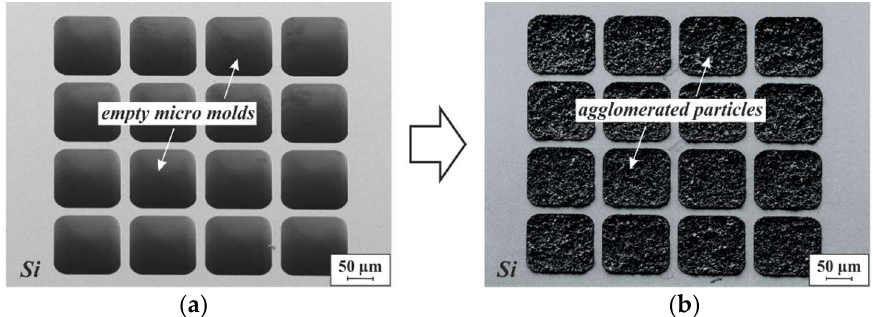
Figure 6. ( a ) SEM micrograph of a micro-mold pattern etched into a silicon substrate with DRIE. The mold cavities are ~400 µm deep and 125 µm × 125 µm in size. ( b ) SEM micrograph of 3D microstructures agglomerated from NdFeB powder with 5 µm mean particle size by 75 nm ALD-Al 2 O 3 , using the mold shown in ( a ).